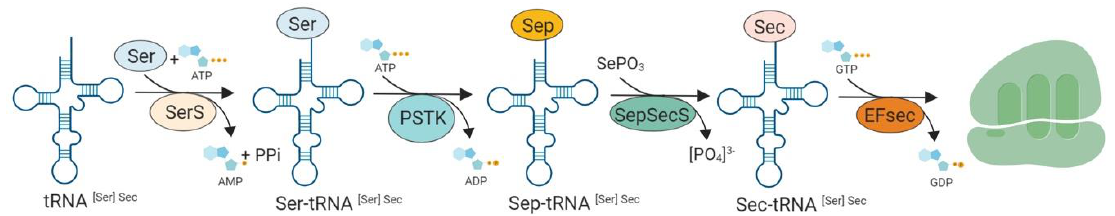
Figure 1. Synthesis and co-translational incorporation of selenocysteine into selenoproteins in humans.